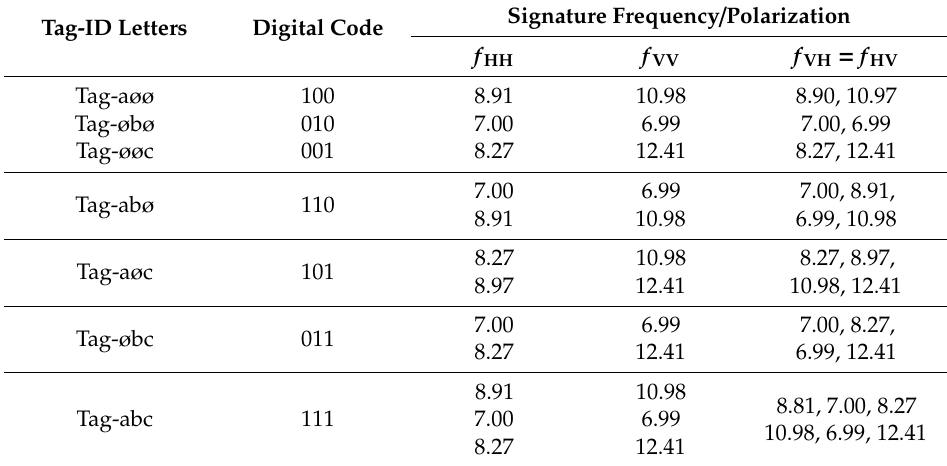
Table 5. Tag-ID Letters’ digital code and resonant frequency signatures (GHz) (ø represents no letter). Tag-ID Letters